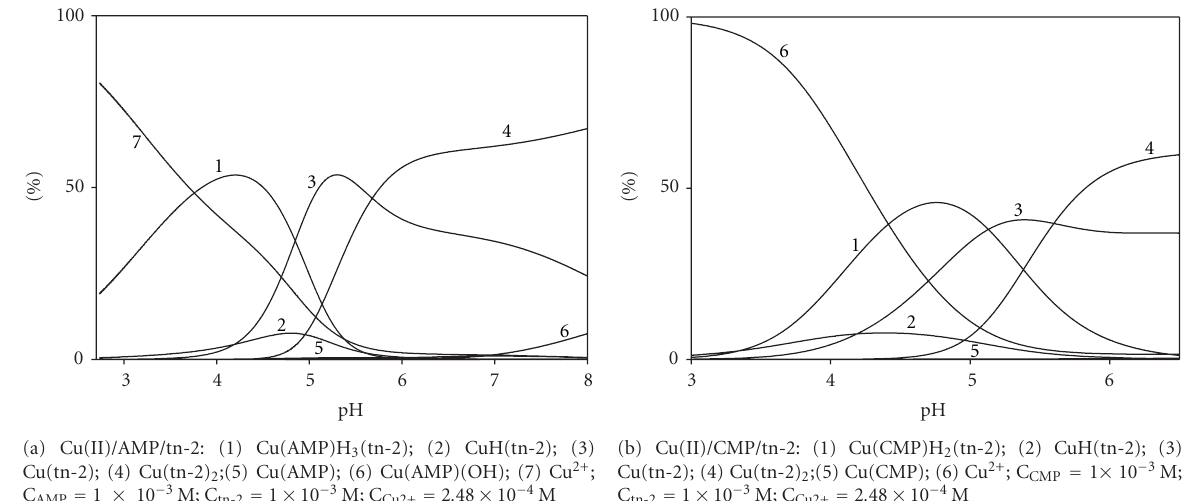
Figure 7: Distribution diagrams for the Cu(II)/AMP/tn-2 and Cu(II)/CMP/tn-2 systems; percentage of the species refers to total metal.